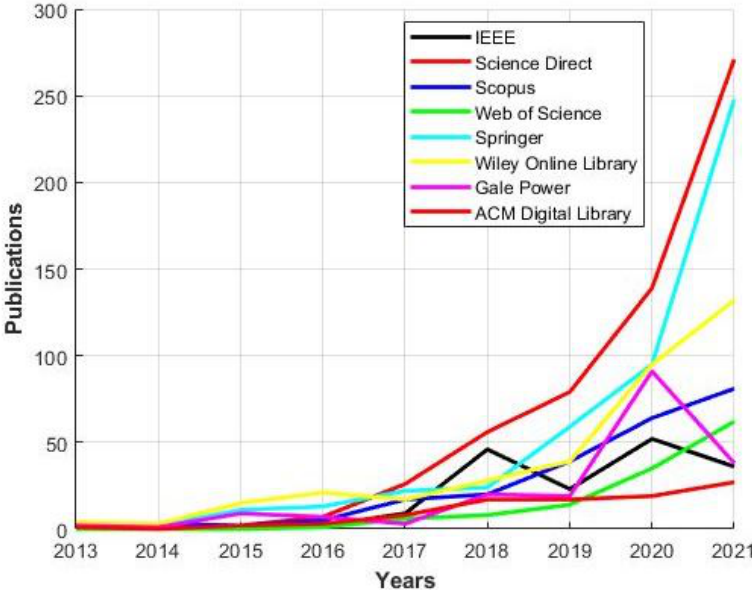
Figure 2. Publications per year related to the topic.